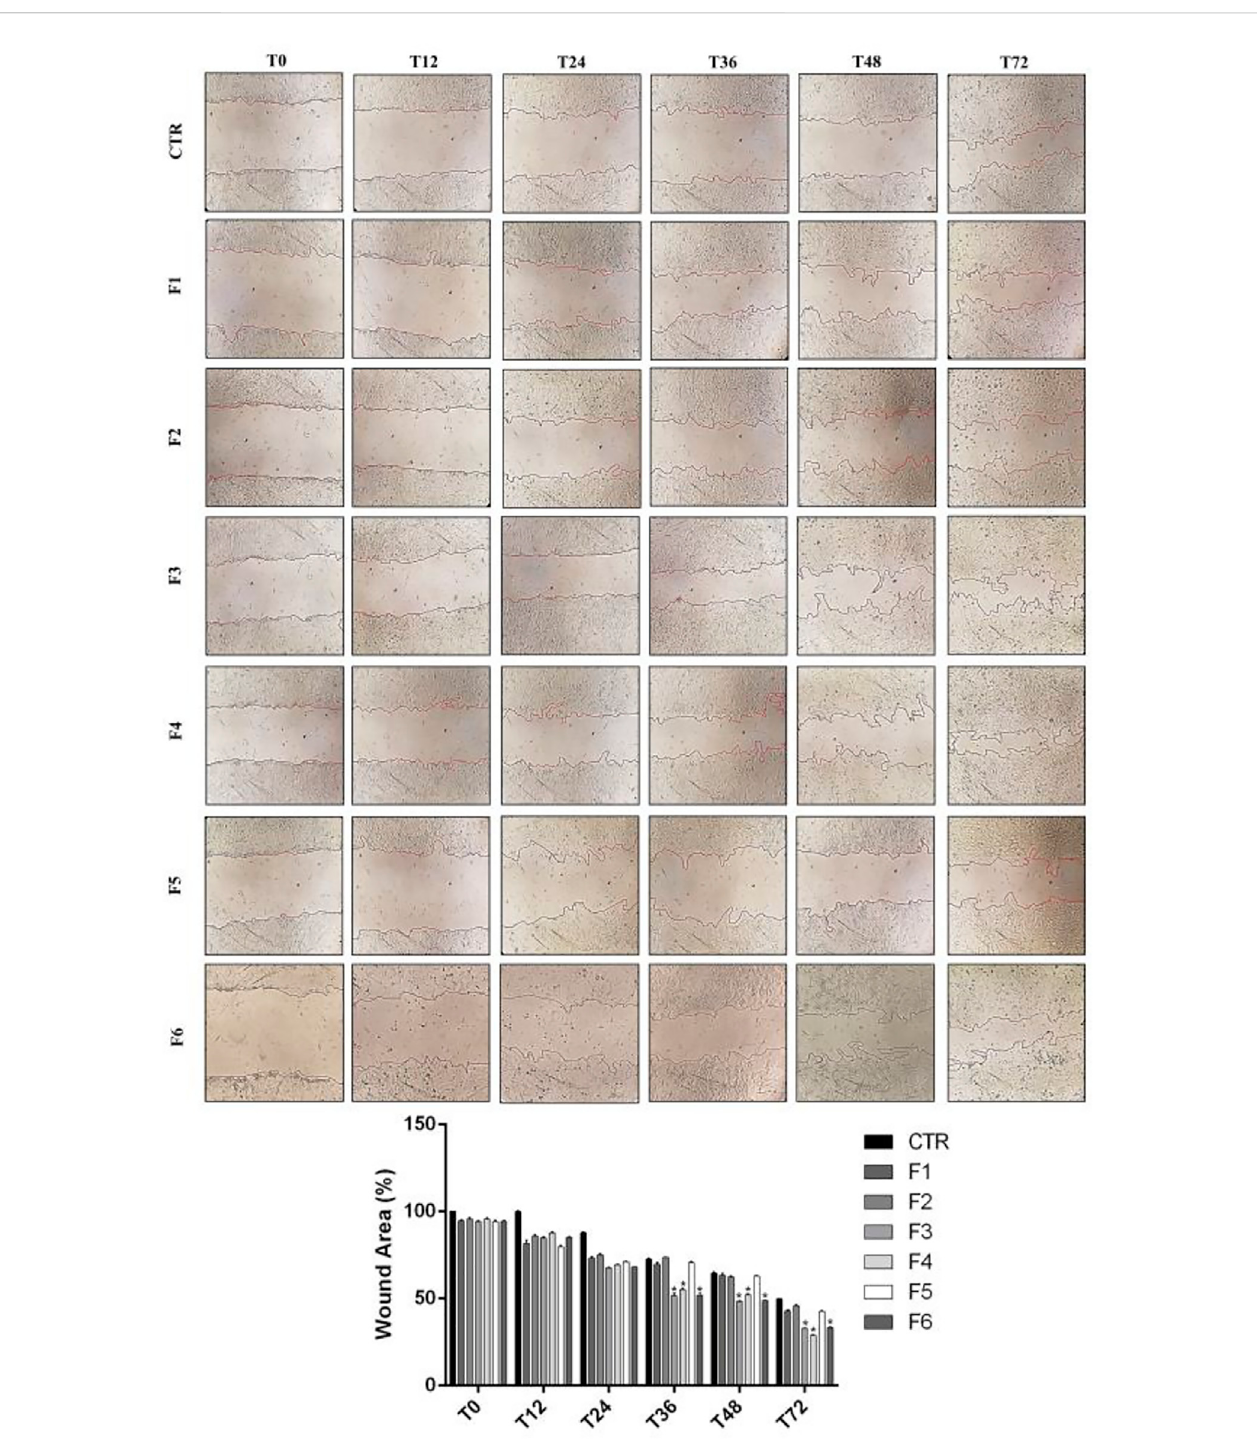
FIGURE 1 Wound healing in SIRCs monolayer. (Top Panel) Representative images of wound healing assays performed in SIRCs exposed to the six different formulations at 0, 12, 24, 36, 48 and 72 h. (Bottom Panel) The bar graph shows the average wound area expressed in the percentage of CTR. * p < 0.01 vs. F1, F2 and F5 as determined by one-way ANOVA followed by the Tukey ’ s post hoc test. Data are shown as mean ± SD of fi ve independent experiments ( n =